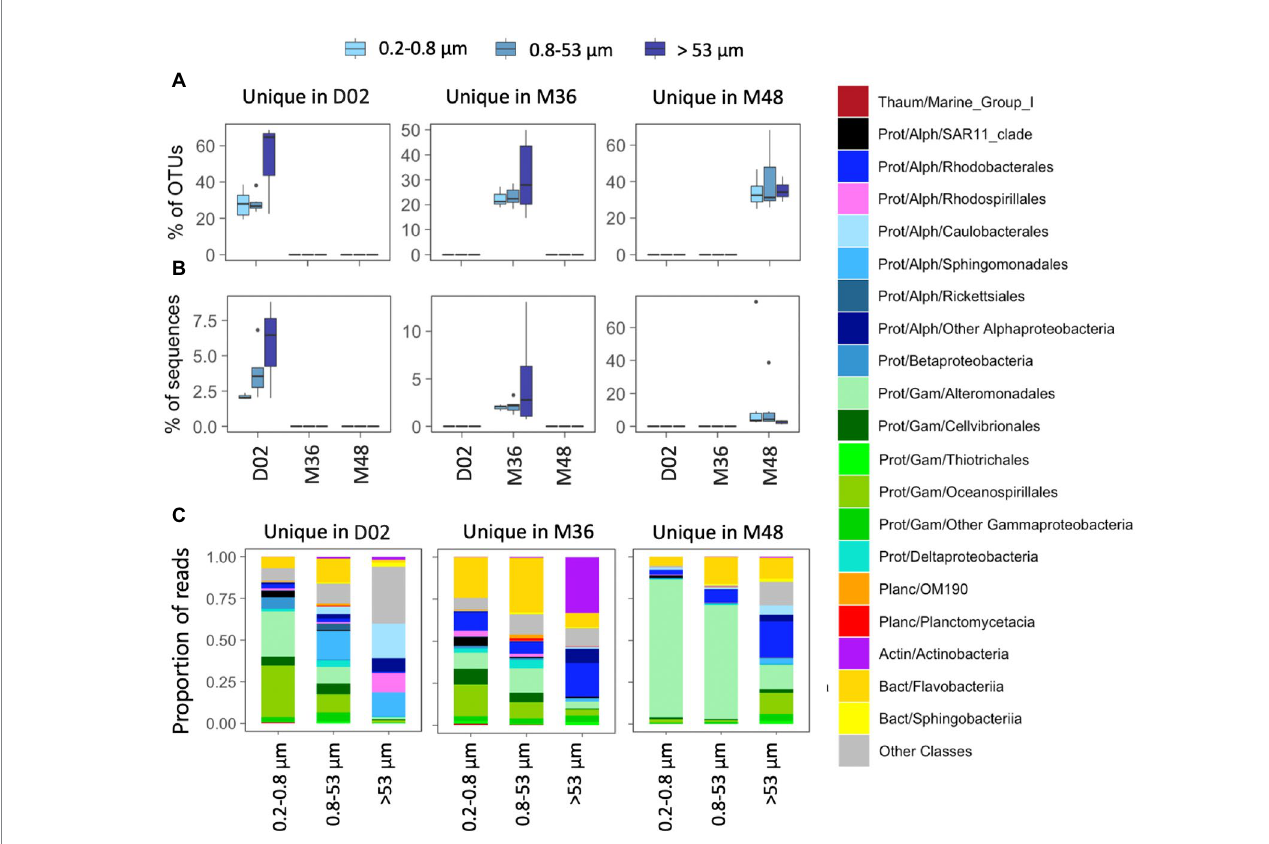
FIGURE 4 (A,B) Contribution in terms of % OTUs (A) or sequences (B) of those OTUs detected exclusively in one station (“unique” OTUs). (C) Taxonomic composition of unique OTUs in the three size-fractions. The classification was performed at the class level although in some cases the main orders are also indicated.